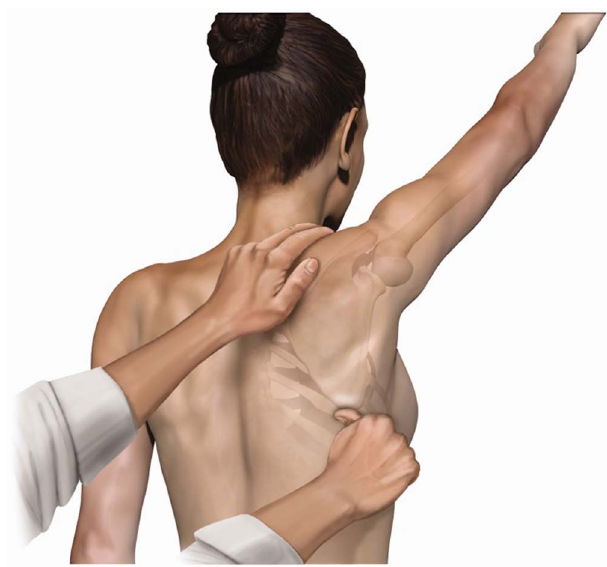
Figure 2. The scapular assistance test (SAT), a manually assisted examination